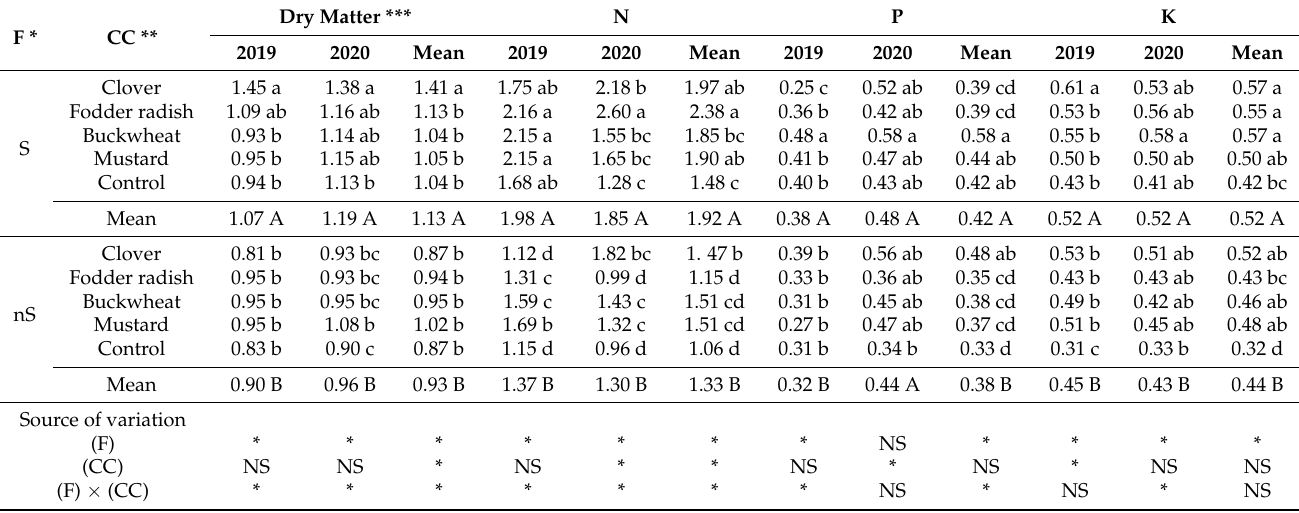
Table 2. Dry matter and macronutrient analysis of winter garlic bulbs cultivated under sulfur and catch crops in